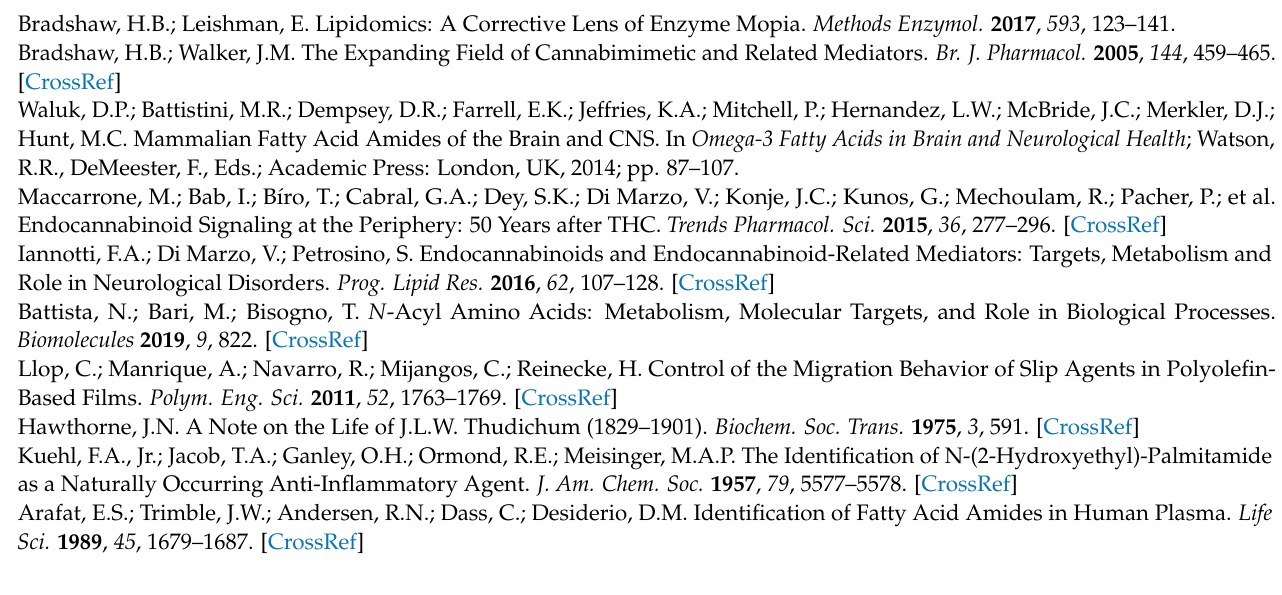
multiplicity of the signals. Figure S6: 13 C NMR (151 MHz, CDCl 3 ) of FA-3 , the inset shows clusterd signals. Figure S7: 1 H NMR (600 MHz, DMSO) of FA-4 , the inset shows multiplicity of the signals. Figure S8: 13 C NMR (151 MHz, DMSO) of FA-4 , the inset shows clusterd signals. Figure S9: The EIC peak and mass spectrum of the N -oleoylethanolamine standard. Figure S10: Targeted MS/MS spectra of endogenous N -oleoylethanolamine in the T. castaneum extract at 20 eV collision energy displaying expected primary fragment ion, m/z